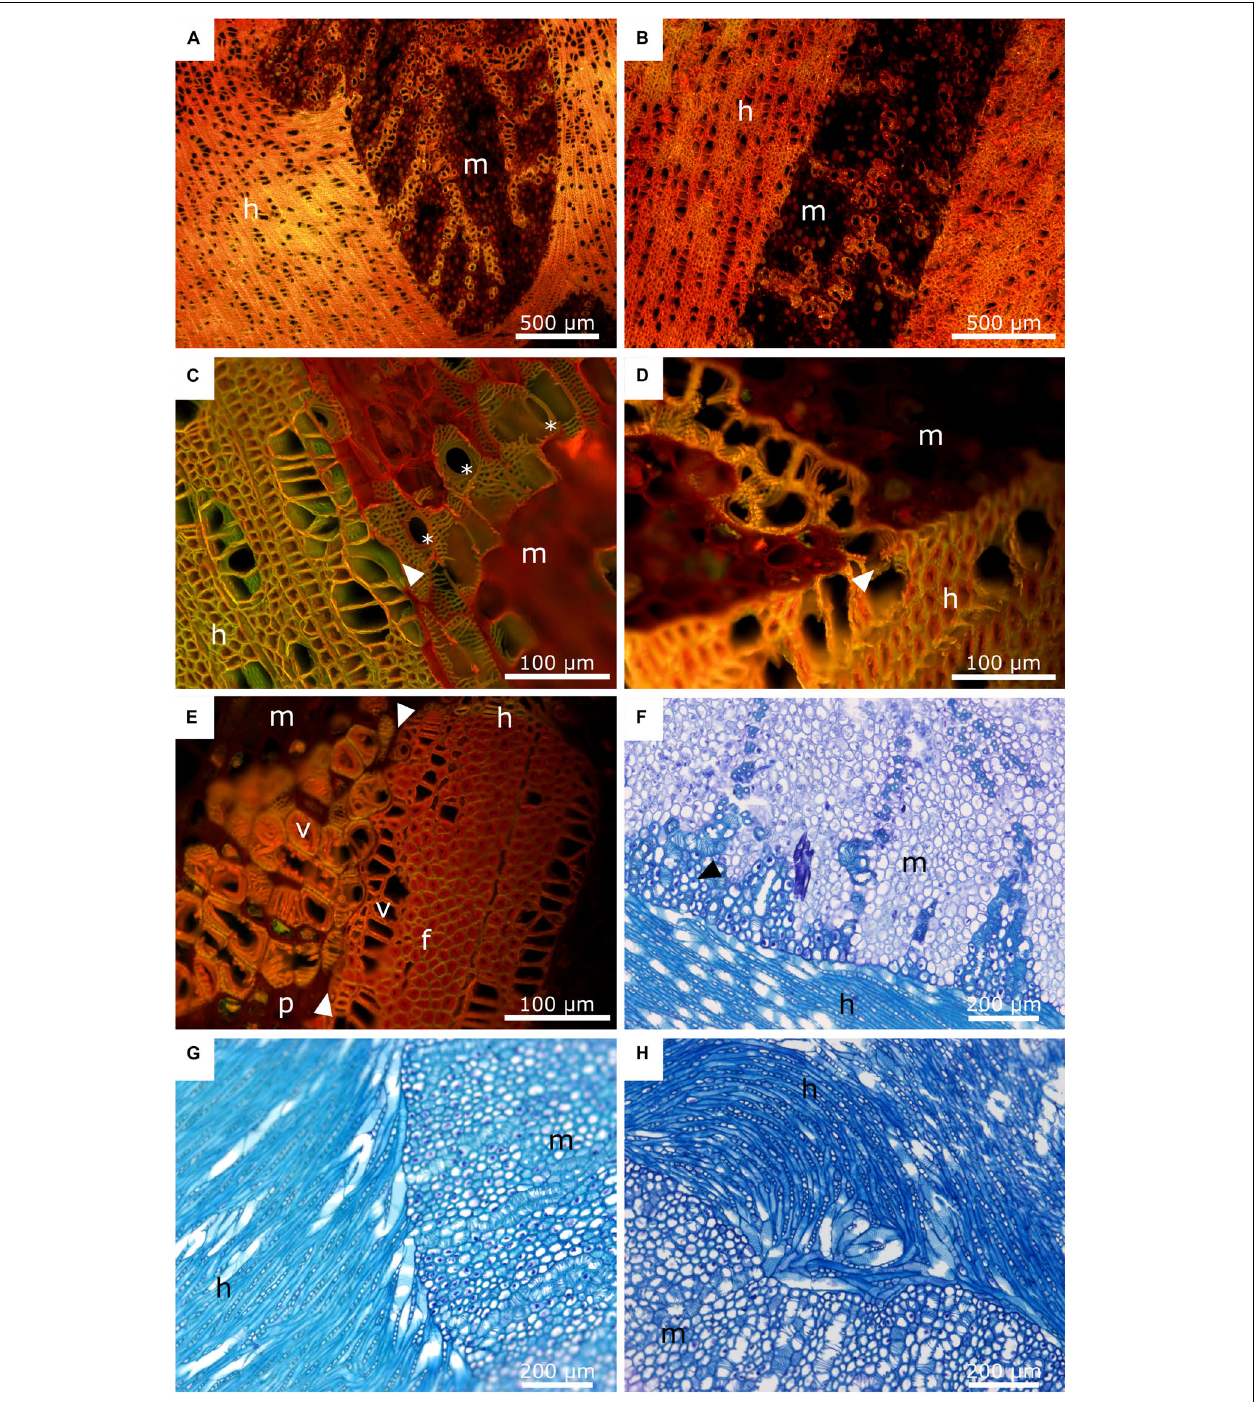
FIGURE 7 | Anatomy of the mistletoe-host interface. The mistletoe haustorium/sinkers and the host wood are marked with “m” and “h”, respectively. (A,B) Acridine orange staining of mistletoe sinkers and their host. The sinkers are sectioned longitudinally. The transverse plane of the host wood is shown. (C,D) Acridine orange staining of the interface of a mistletoe haustorium (longitudinal) and the host wood (transverse). The black arrows mark the contact area between the vessel elements of the host and the mistletoe tracheids. The asterisks mark perforation plates of the mistletoe vessel elements. (E) Acridine orange staining of a mistletoe plant (longitudinal) and its host (transverse). The white arrows mark the interface between the two species. Vessel elements (v), host wood fibres (f), and mistletoe parenchyma (p) are visible. (F) Toluidine blue staining of the interface between the main haustorium of the mistletoe (transverse) and its host (tangential). The black arrow marks mistletoe parenchyma cells with thickened cell walls. (G,H) Toluidine blue staining of the host-mistletoe interface. The host is oriented tangentially. The mistletoe haustorium is cut transversally. (G) Host vessel elements change their orientation and align with the mistletoe interface. (H) Host vessel elements are clustered in a